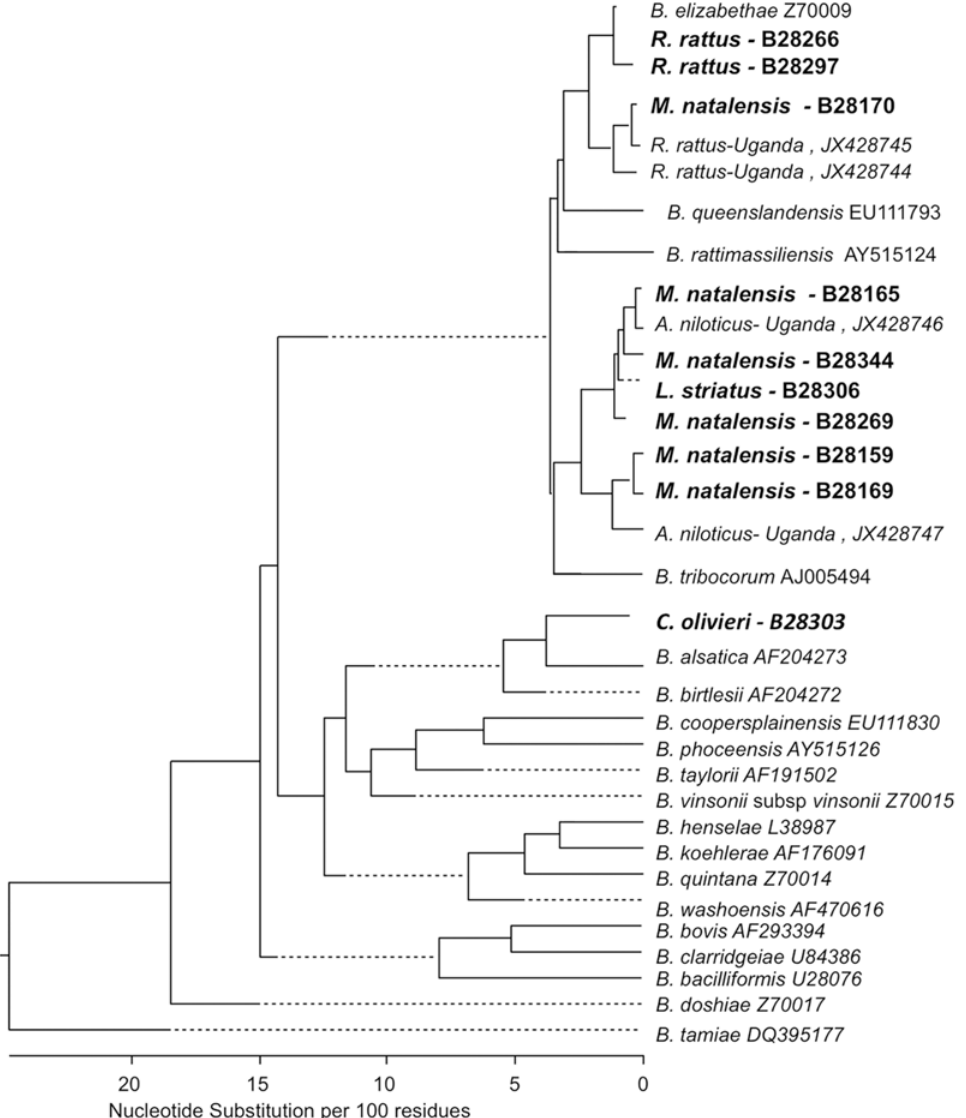
Fig 3. Phylogenetic tree of Asembo Bartonella isolates. Phylogenetic tree of Bartonella isolates obtained from Asembo small mammals (shown in bold) and previously described reference strains from sylvatic rodents trapped in Africa based on sequence analysis of the citrate synthase ( gltA ) gene. The phylogenetic tree was constructing using the neighbor-joining method. Dotted lines indicate negative branch